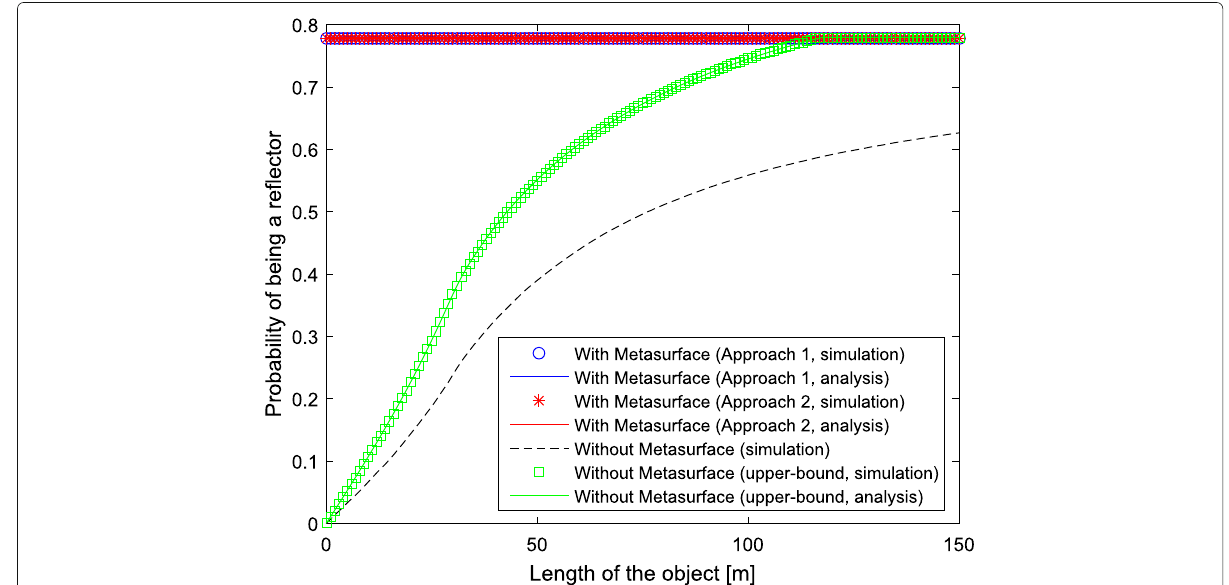
Fig. 7 Probability of being a reflector versus the length of the object. Setup: R net = 30 m, location of the transmitter ( 0,3 ) , location of the receiver ( 20,20